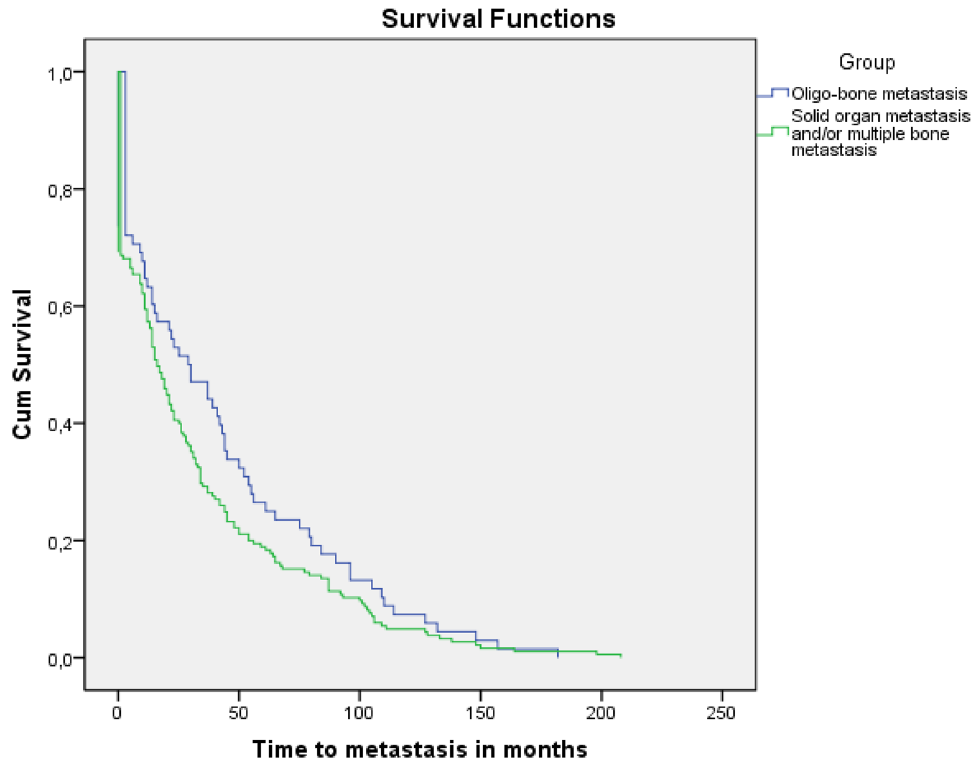
Figure 4. Time from primary diagnosis of breast cancer to the occurrence of OMBD or multimetastatic disease. (OMBD: 41.9 ± 5.5 months, widespread metastatic disease: 32 ± 3.0 months; p =